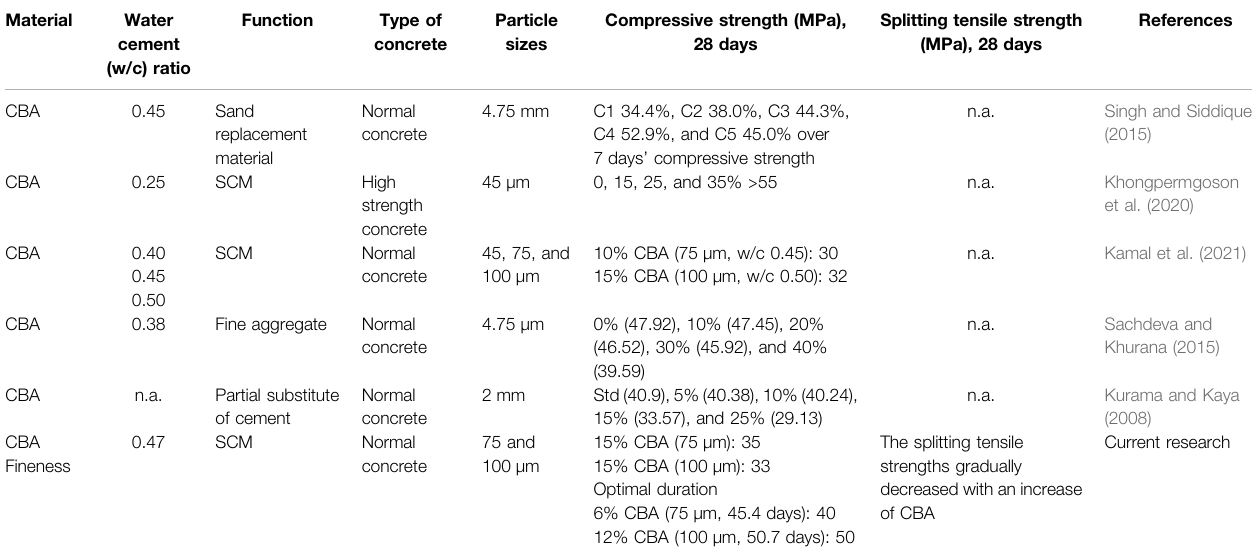
TABLE 1 | Review studies on concrete